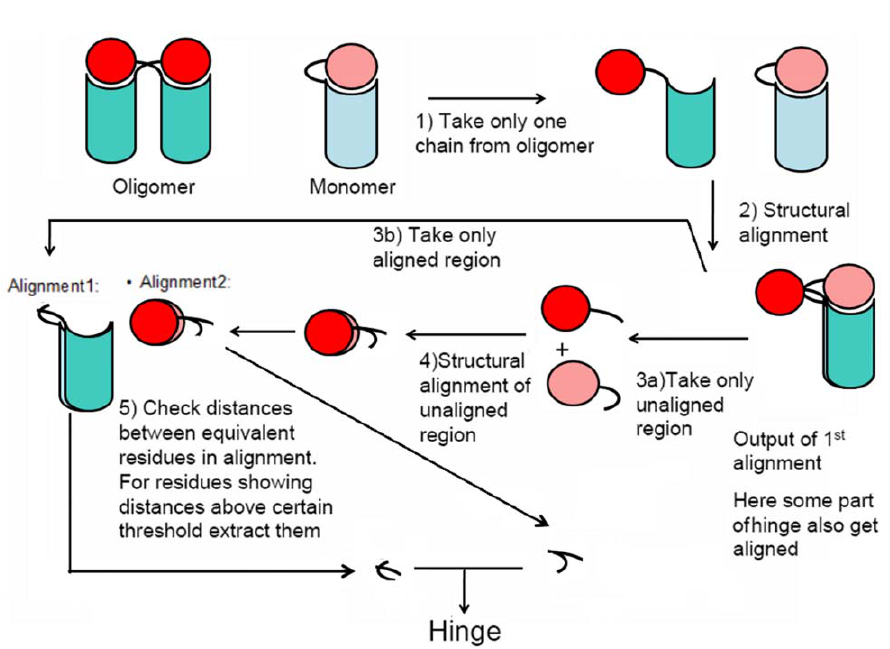
Figure 3. Flowchart of Hinge Identification using structural alignment.